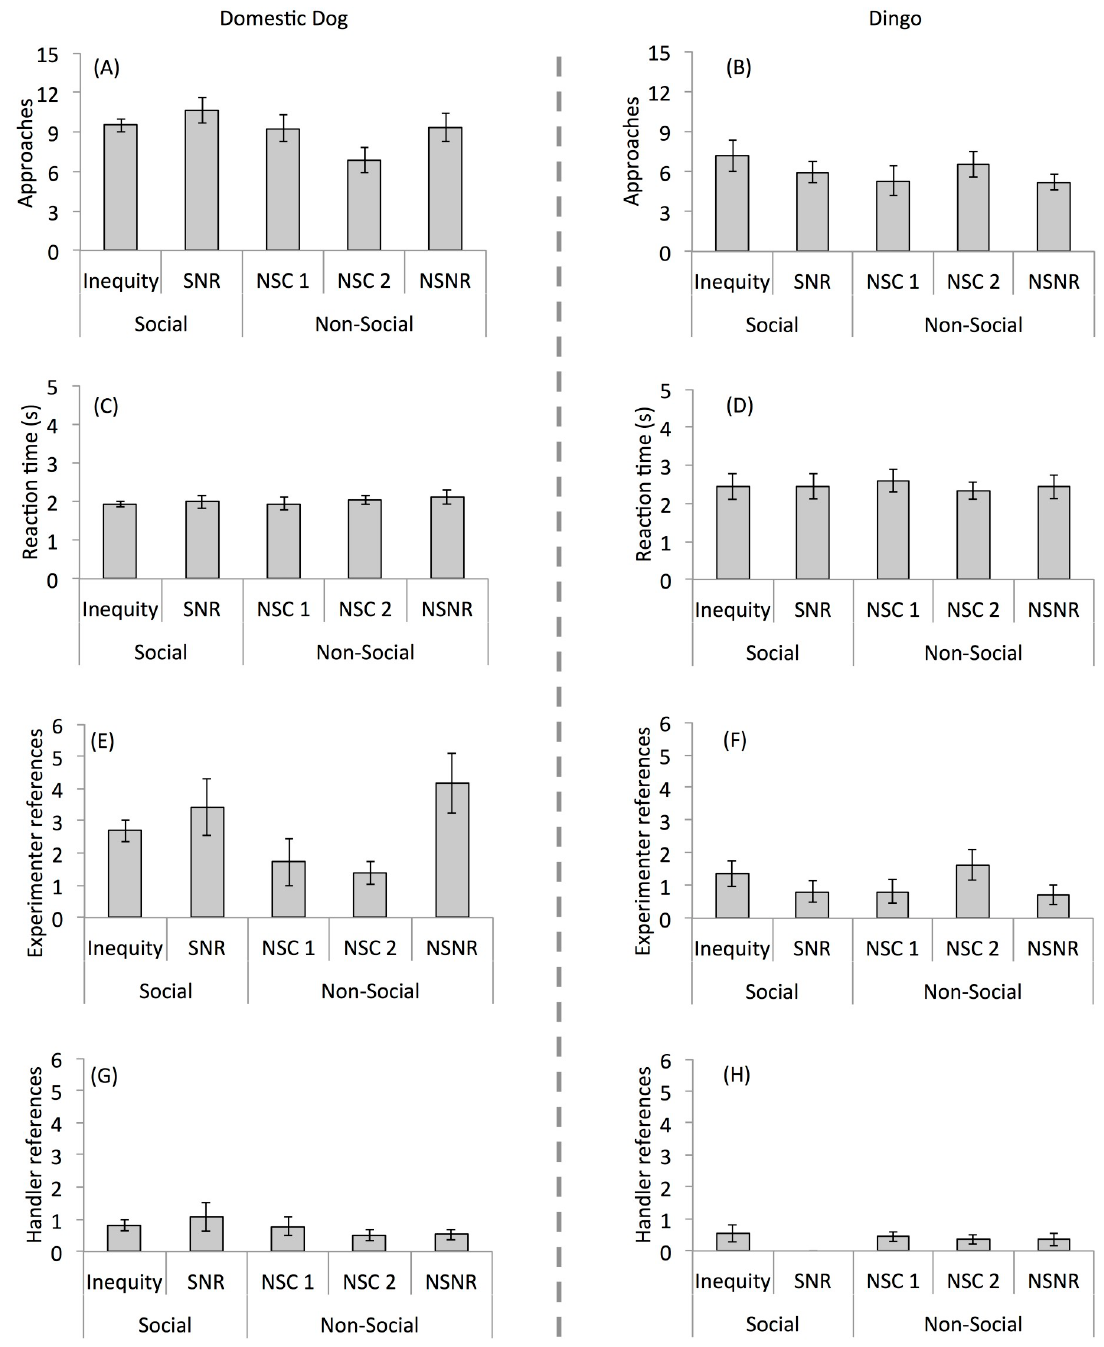
Fig 3. Bar plots showing test session measures. Bar plots show approaches (A, B), reaction time (C, D), experimenter references (E, F) and handler references (G, H) for domestic dogs (left column) and dingoes (right column) across conditions. Conditions were as follows: Inequity, subject not rewarded while partner received a reward; Social No Reward (SNR), neither subject nor partner rewarded; Non- Social Control 1 (NSC1), subject not rewarded and partner absent but reward delivered to partner’s empty plate; Non-Social Control 2 (NSC2), identical to NSC1 but with a non-social baseline; Non-Social No Reward (NSNR), partner absent and no food distributed on plates. Error bars show standard error of the mean.